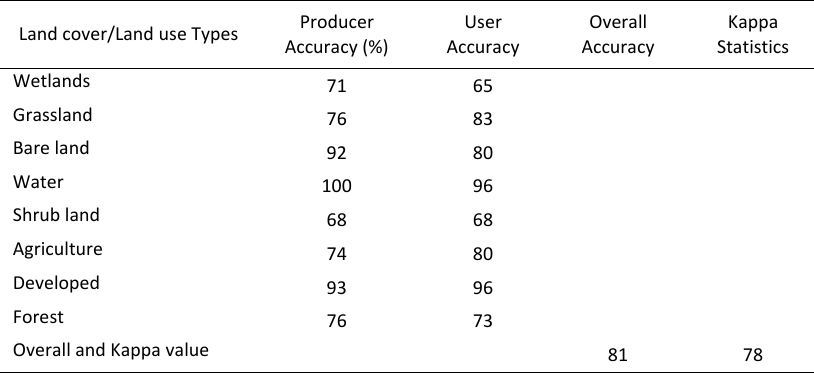
Table 2: Generated Accuracies from Error Matrix Table for Land cover/Land use classification